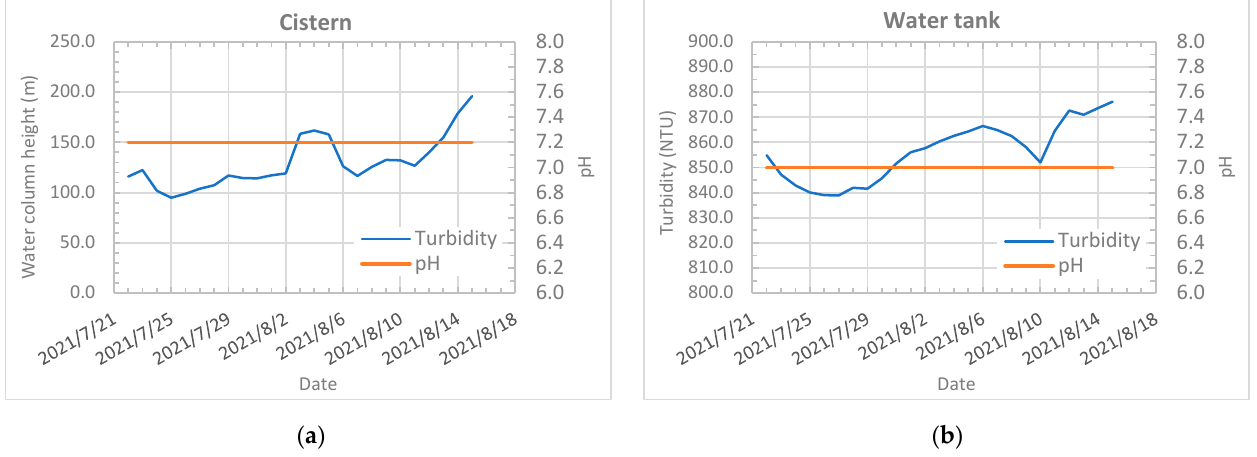
Figure 20. Water quality measurements retrieved from: ( a ) open cistern; ( b ) closed tank.